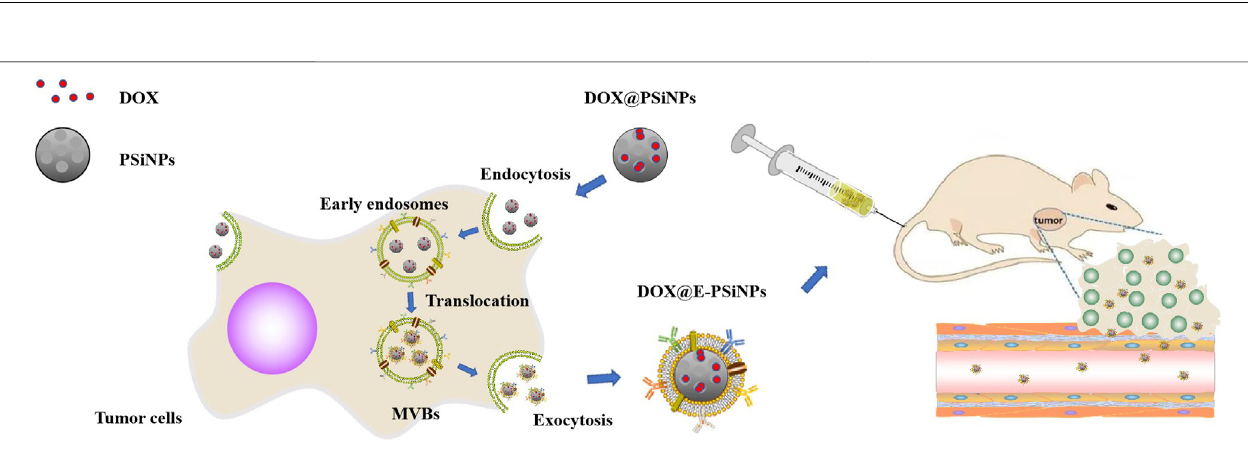
FIGURE9| Preparationandef fi cacyofDOX@E-PSiNPsastumor-targeteddrugs.DOX@PSiNPsaretakenupintotumorcellsthroughendocytosisandlocalizedin multivesicularbodies(MVBs)toprepareDOX@E-PSiNPs.WiththefusionofMVBsandcellmembrane,DOX@E-PSiNPsarereleasedintotheextracellularspacethrough exocytosis. After intravenous injection, DOX@E-PSiNPs ef fi ciently accumulate in tumor tissues and penetrate deeply into tumor parenchyma.